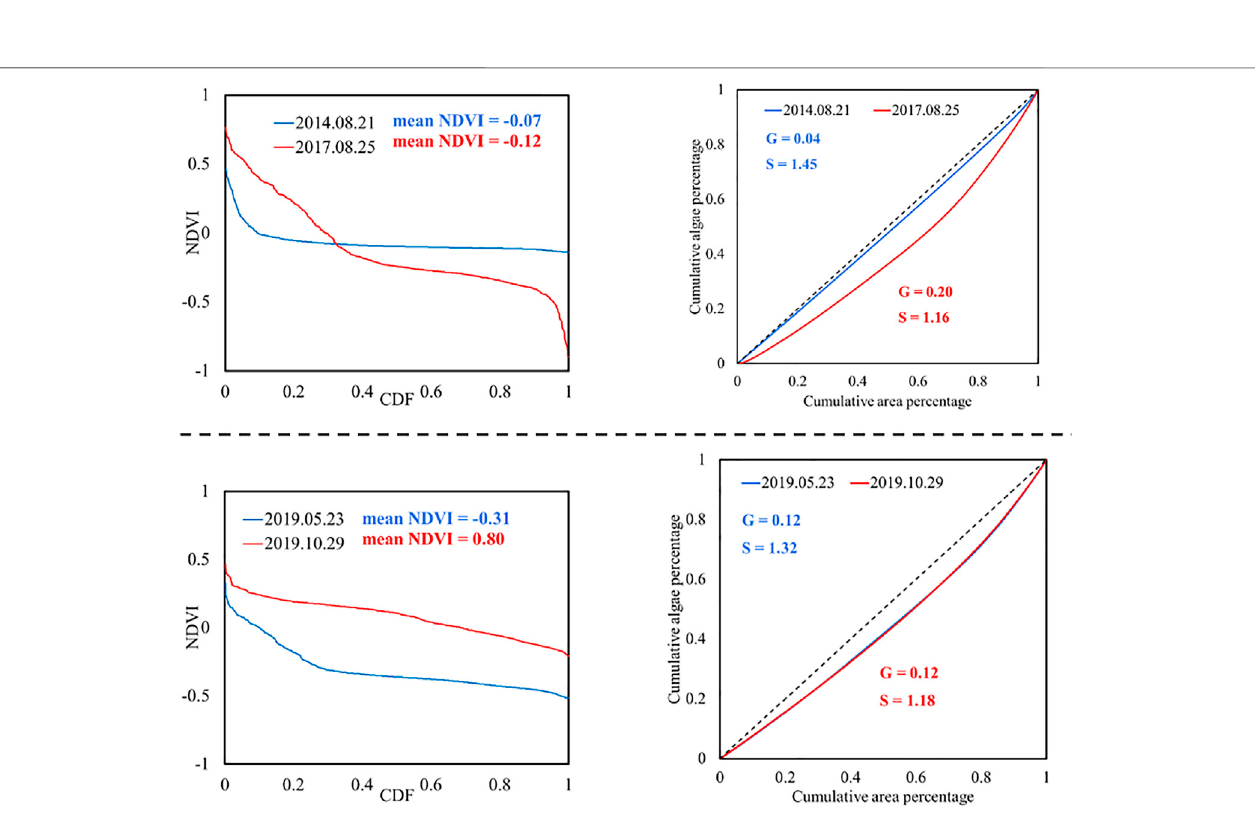
FIGURE 16 | Comparison between CDF curve and Lorenz